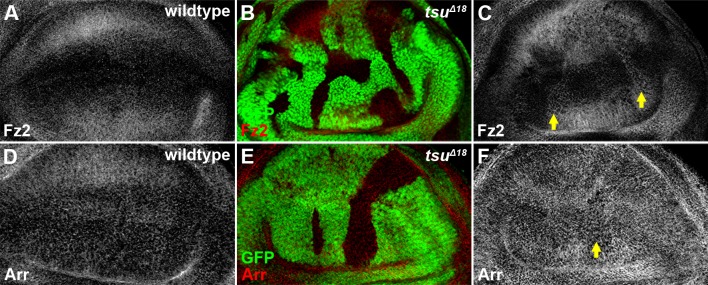
The pre-EJC does not obviously regulate the expression of Fz2 and Arr.Shown are expression patterns of Fz2 (A) and Arr (D), two co-receptors for Wg morphogen reception, in wildtype wing discs. The expression of Fz2 (B,C) was slightly upregulated in some tsuΔ18 clones, while the expression of Arr (E,F) remained largely unchanged.